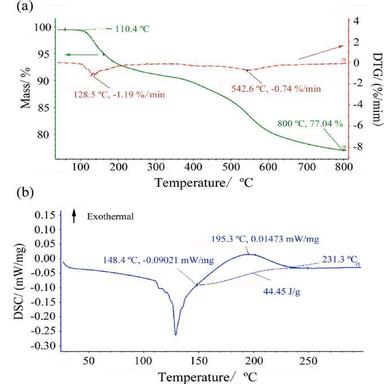
Thermal analysis curves of the adhesives: (a) TG-DTG and (b) DSC.